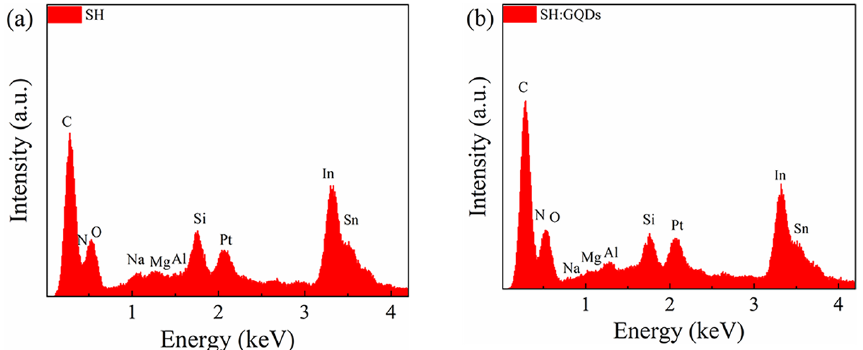
Figure 2. EDS analysis of the ( a ) SH thin film and ( b ) SH/GQD composite film.